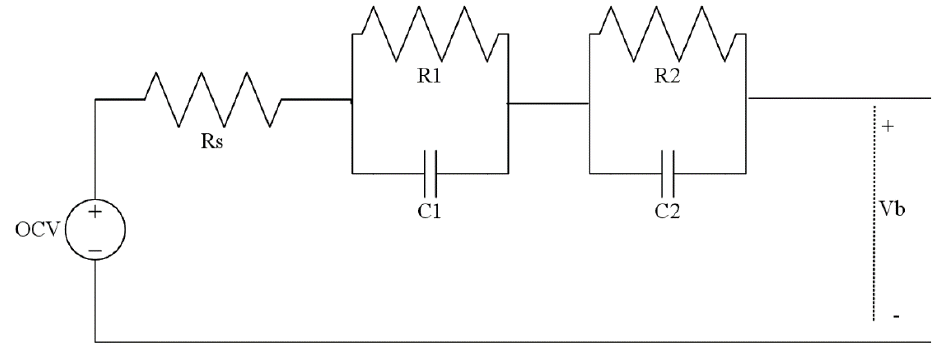
Figure 1. Battery equivalent circuit model with 2nd-order RC branch, Reproduced from [37].